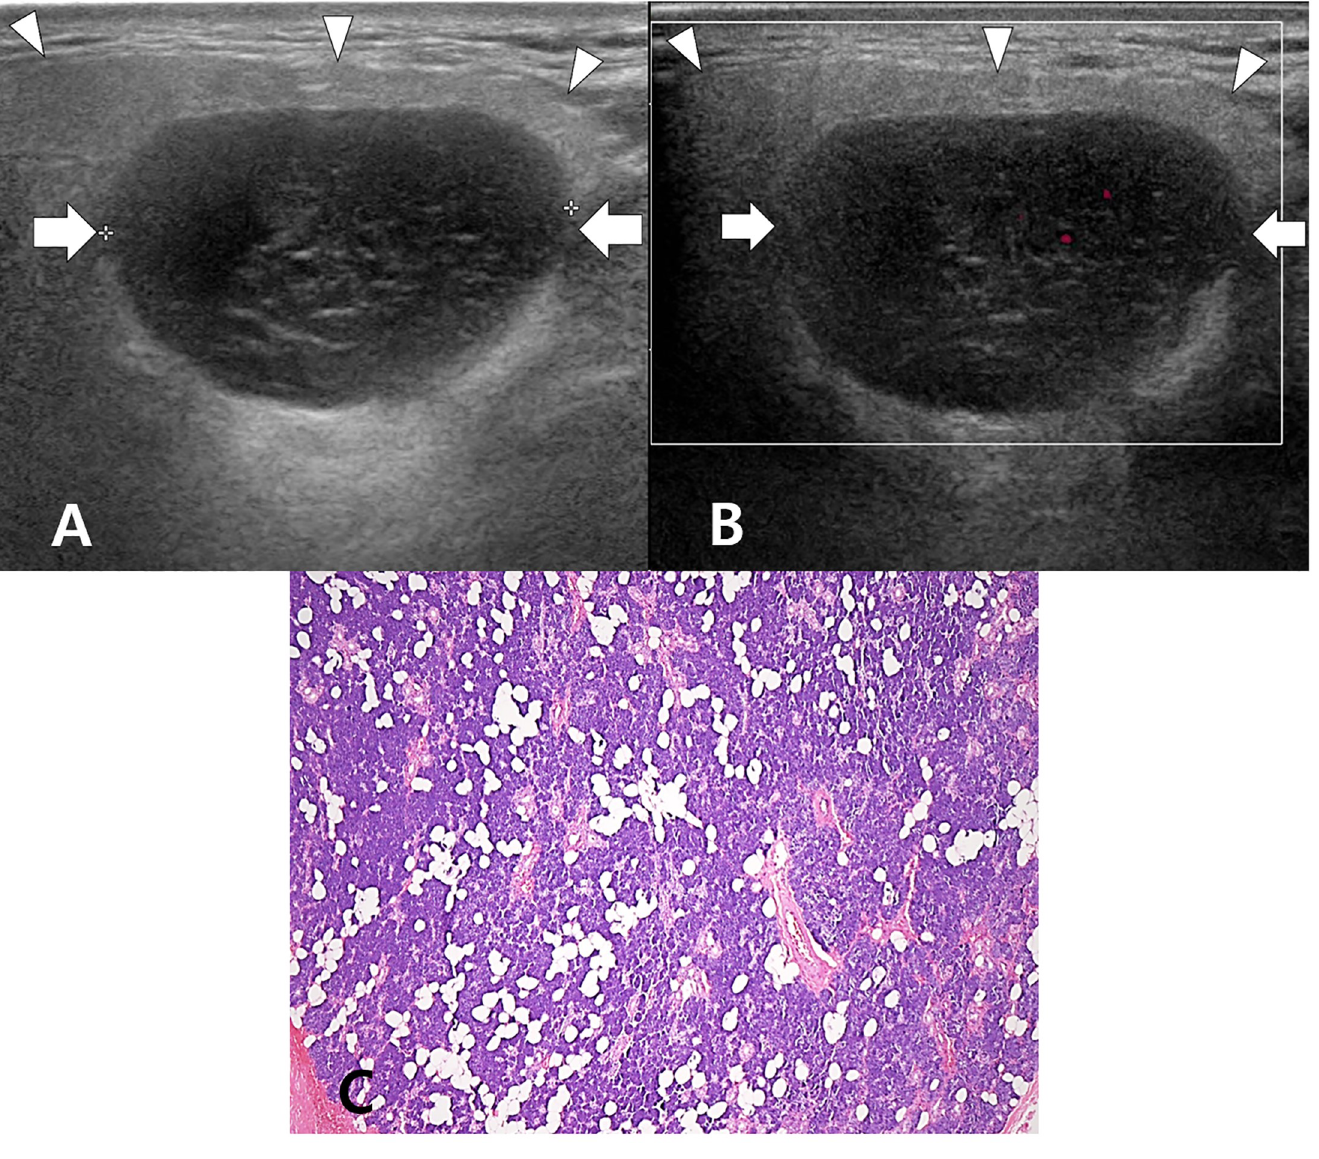
Fig 1. A 45-year-old woman with category 1 on US and normal parotid parenchyma in histopathology. On the longitudinal gray-scale sonogram (A), a Warthin’s tumor (arrows) in the right parotid gland is observed, and the right parotid gland (arrowheads) shows normal parenchymal echogenicity, fine parenchymal echotexture, normal gland size, and a smooth margin. On the longitudinal color Doppler sonogram (B), normal parenchymal vascularity is observed. In the histology slide (C), the right parotid gland shows a normal parenchyma with serous acini and no inflammatory cells (hematoxylin and eosin stain, × 100).